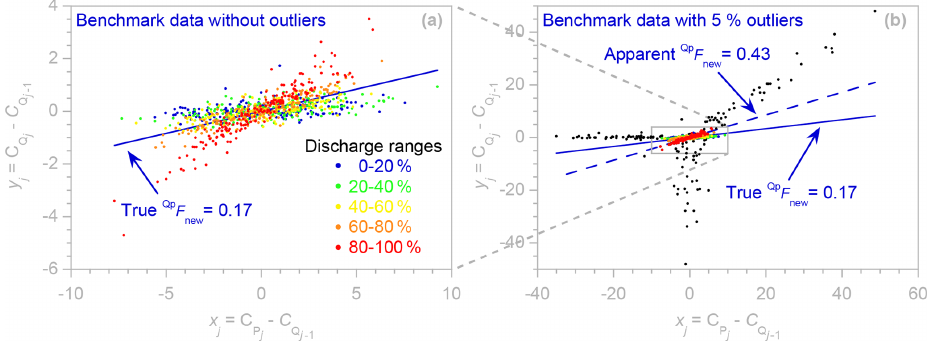
Figure 2. Regression relationship (Eq. 1) used to estimate the event new water fraction Qp F new , using (a) the outlier-free benchmark data of Fig. 1a, with different percentile ranges of discharge shown in contrasting colors, and (b) the outlier-corrupted benchmark data of Fig. 1b, with outlier points shown in black. The axis frame of the outlier-free plot (a) corresponds to the small gray rectangle in panel (b) . In panel (a) , five different percentile ranges of the discharge distribution are shown in contrasting colors. The stronger coupling between tracer fluctuations in precipitation and streamflow at higher discharges, as seen in the differently colored points in panel (a) , reflects a larger new water contribution to streamflow. The event new water fraction Qp F new is the average fraction of streamflow that is composed of precipitation that fell during the current sampling interval and is calculated from the regression slope between fluctuations in precipitation and streamflow ) , each expressed relative to the previous streamflow sample’s tracer concentration ( C Q tracer concentrations ( C P and C Q j j this reference value appears on both axes of the regression plot, anomalous streamflow tracer values will appear as positively correlated outliers. These points, as well as the x j outliers generated by anomalous precipitation tracer values, may have substantial leverage on the fitted regression line, leading to distorted estimates of the regression slope Qp F new